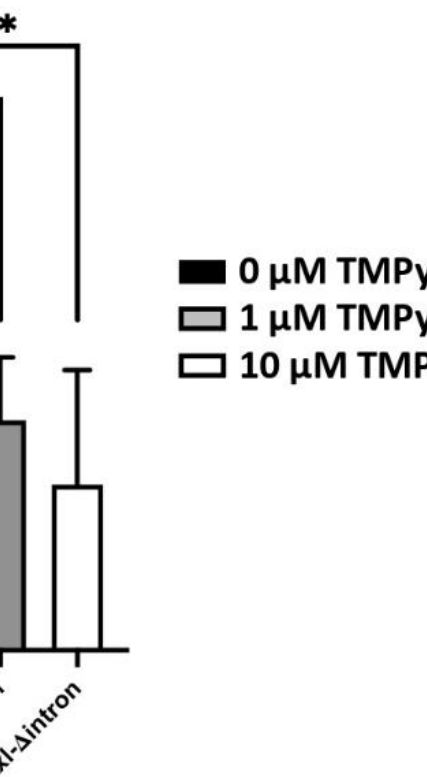
Figure 4. G-quadruplexes facilitates Axl expression. Hela cells were transfected with the Axl-UTR or Axl- Δ intron constructs. The G-quadruplex stabilizer TMPyP4 was added into the culture two hours after transfection at different concentrations as indicated in the figure. Experiments were repeated twice. Luciferase activity was analyzed and results were presented as mean ± SD. Student t -test was performed to compare with the luciferase activity from Hela cells transfected with the control. * p < 0.05, ** p < 0.01, ns, not significant.